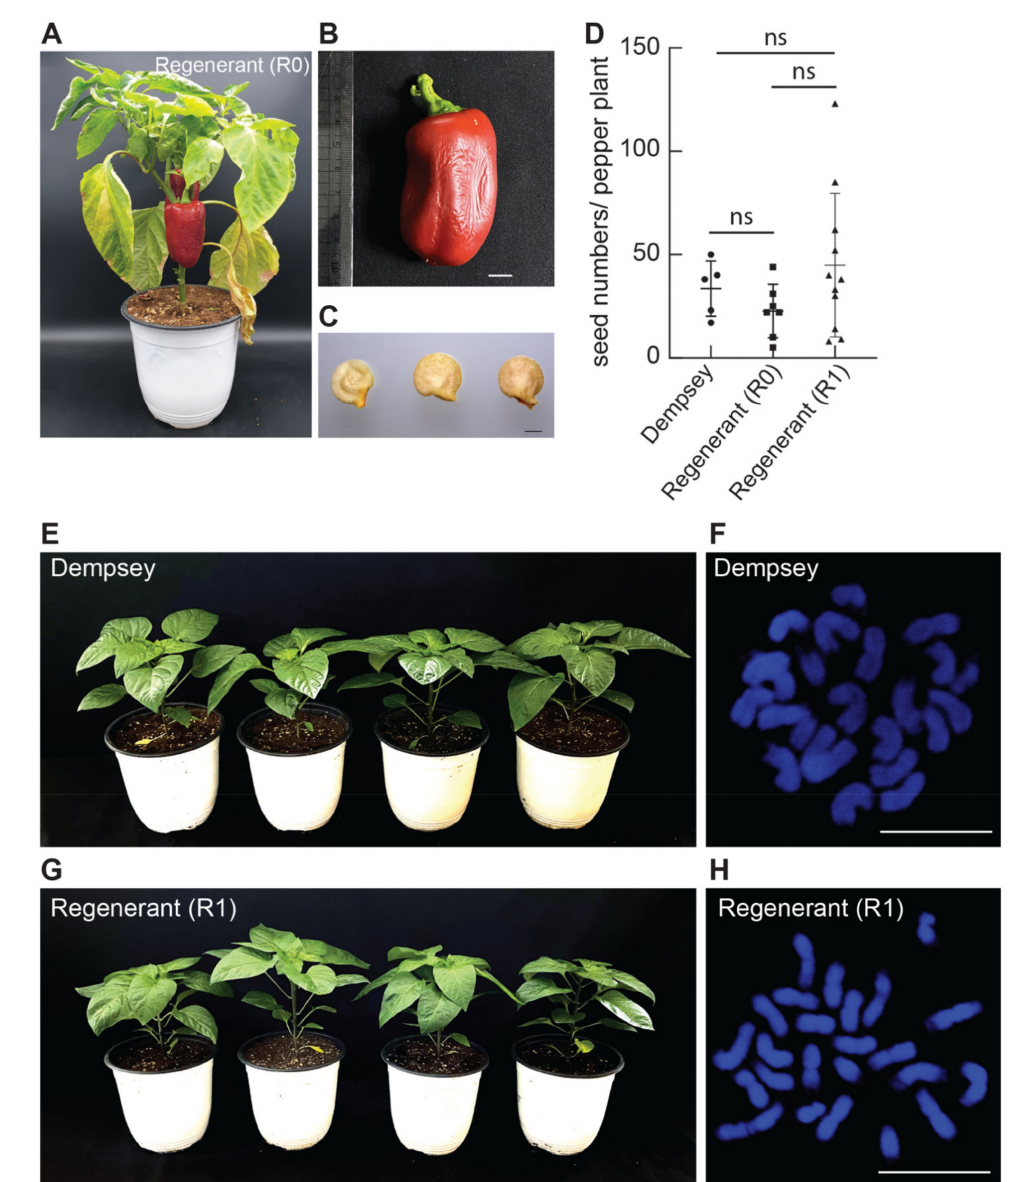
Figure 3. Phenotypic and cytogenetic analyses of ‘Dempsey’ regenerants (R0) and their progenies (R1). ( A ) Representative image of ‘Dempsey’ regenerant (R0) with two mature fruit in 15 cm diameter of pot. ( B ) Harvested fruit of the regenerant, scale bar = 1 cm. ( C ) Harvested seeds from the fruit, scale bar = 1 mm. ( D ) Harvested seeds from five ‘Dempsey’ plants, seven Regenerants (R0), and eleven Regenerants (R1); all plants produced comparable seed numbers, ns: non-significant difference. ( E , G ) 8-week-old, soil-grown ‘Dempsey’ plants ( E ) or Regenerant (R1) plants ( G ) in 15 cm diameter of pot. ( F , H ) Representative images of cytogenetic analysis of ‘Dempsey’ ( F ) or Regenerants (R1) ( H ). Both DAPI-stained images showed unaltered chromosome numbers (2n = 24), scale bar = 10 µ